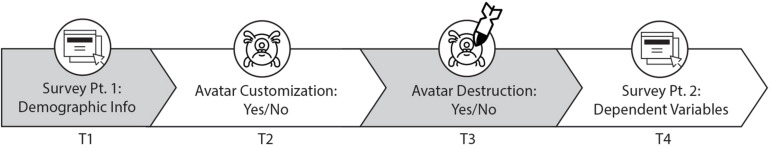
Visualization of the experimental procedures for study 2.